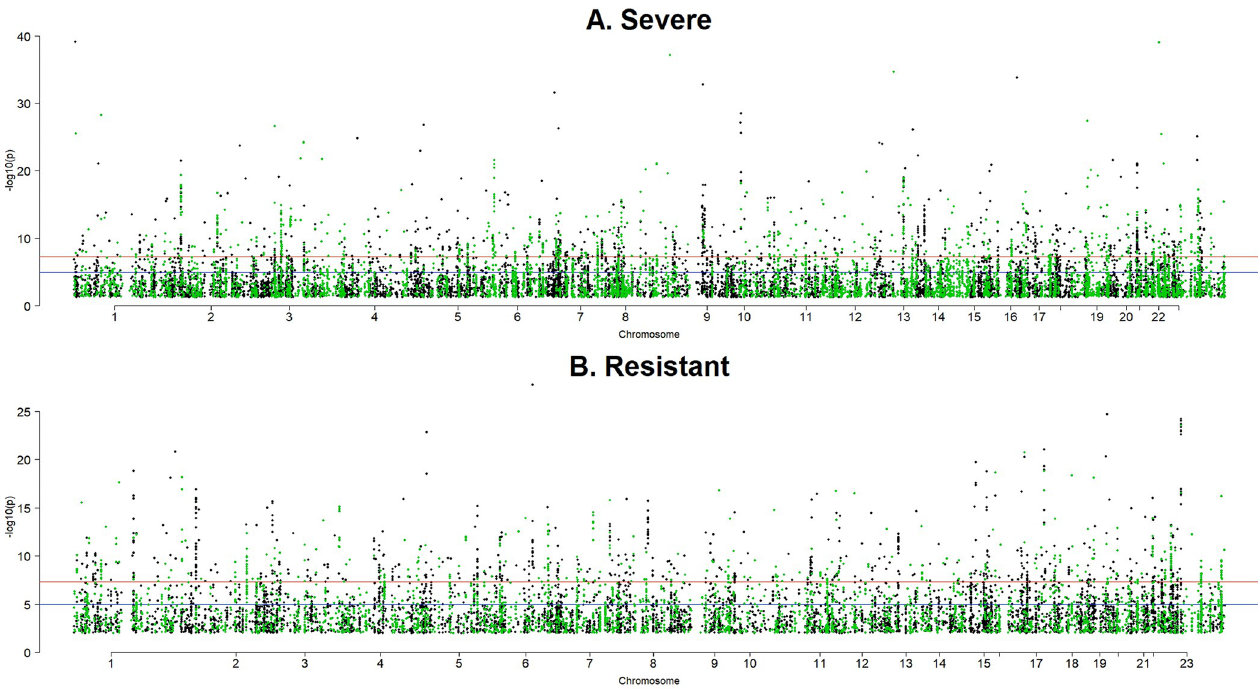
Fig 1. Genome–wide SNP significance for severe (A) and resistant (B) phenotypes with green dots representing SNPs located in exons.